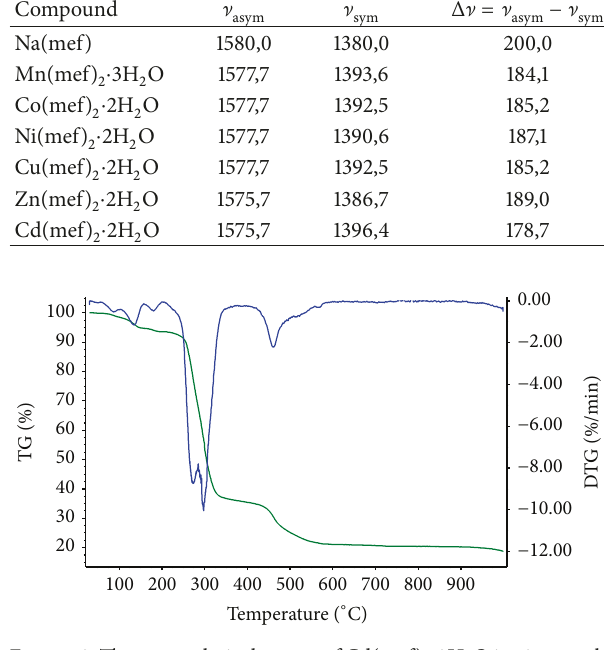
Figure 2: Thermoanalytical curves of Cd(mef) 2 ⋅ 2H 2 O in air, sample mass 7,407